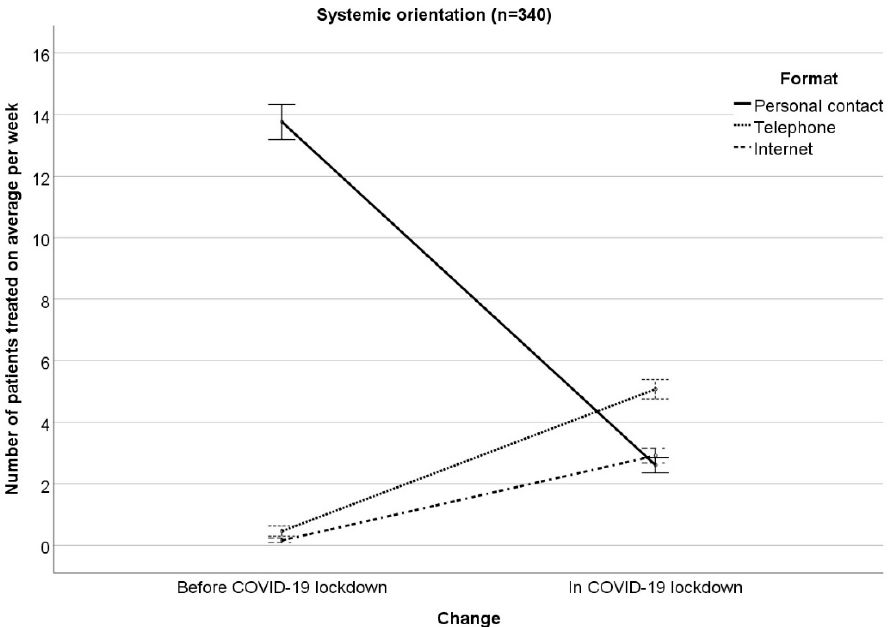
Figure 2. Number of patients treated on average per week in personal contact, via telephone, via Internet in the months before/in COVID-19 lockdown for humanistic orientation. Mean ± 1 standard error.